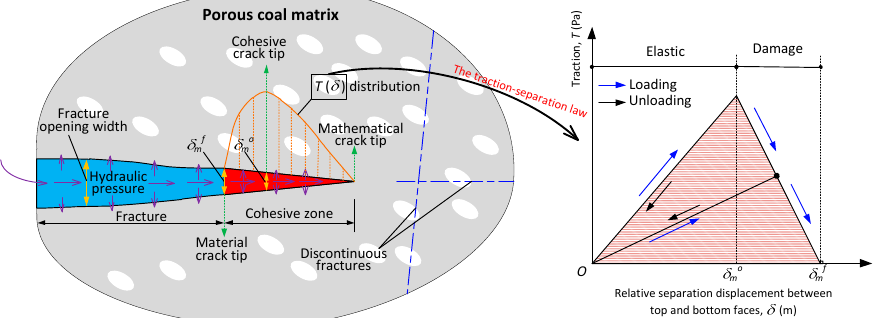
Figure 5. Hydraulic fracture propagation driven by fracturing liquid, and the traction–separation law for cohesive elements. In the blue zone, the cohesive elements are in a complete damage state, whereas those in red zone are in an elastic state or in an incomplete damage state.